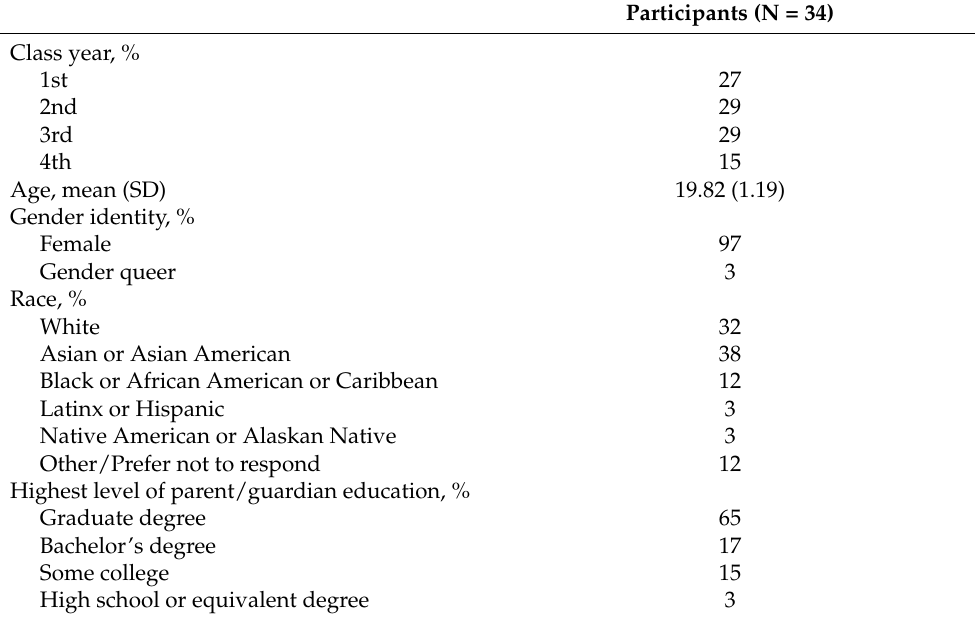
Table 1. Summary of participant